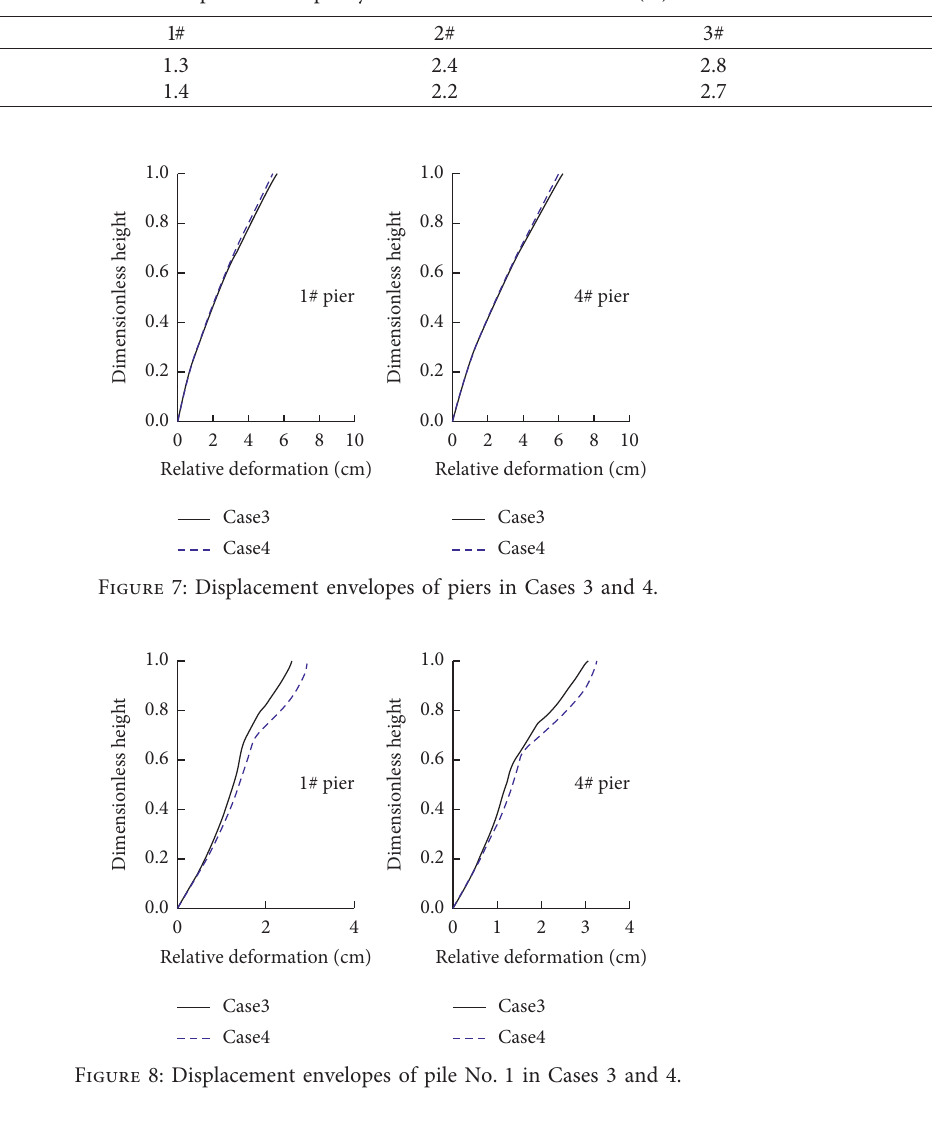
Table 4: Response discrepancy rates for Case 1 and Case 2 (%).